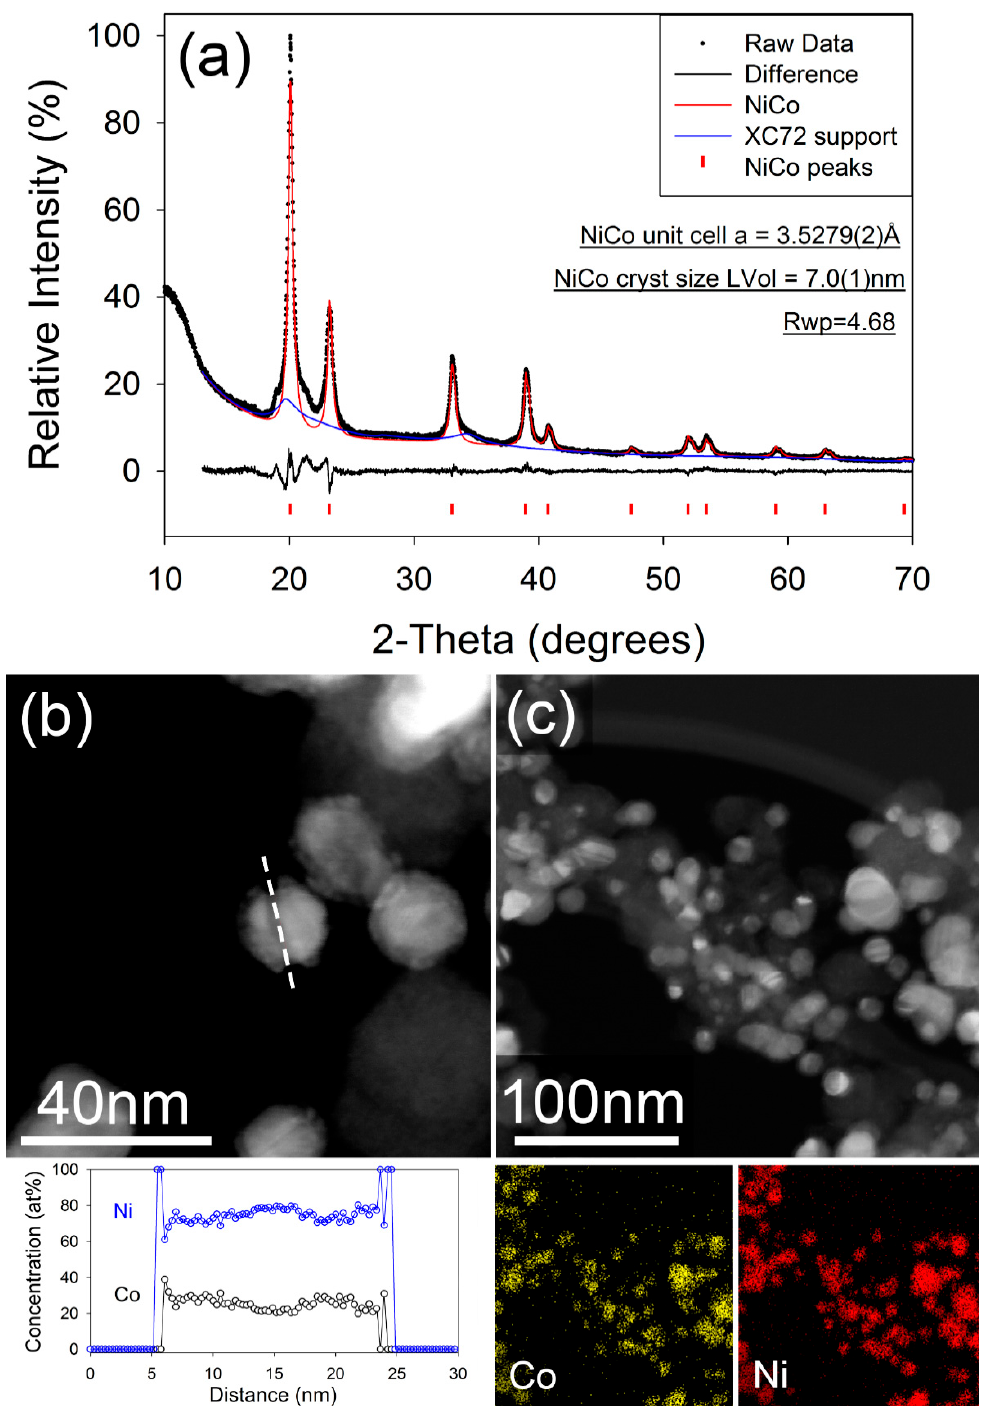
Figure 5. ( a ) Fitted X-ray diffraction pattern for NiCo\C after annealing. Data were collected in capillary transmission mode using a Mo-K α source and modelled using a Rietveld-type approach. ( b ) Dark field image of annealed NiCo/C nanoparticles, with composition measured along the dashed line. ( c ) Dark field STEM image of annealed NiCo/C nanoparticles with corresponding X-ray element maps of Co (yellow), and Ni (red).